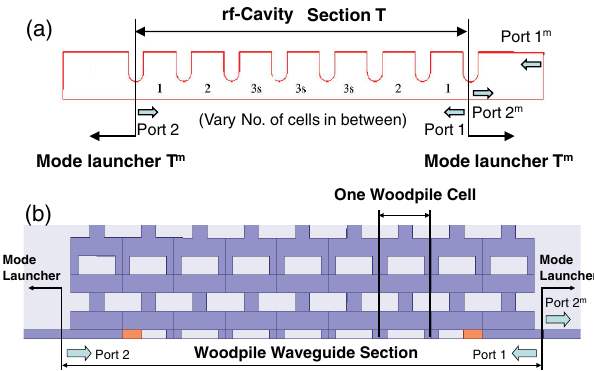
FIG. 3. (a) Mode launchers at the front and back of a multicell rf cavity waveguide to achieve traveling-wave match. (b) An equivalent configuration for a woodpile waveguide and back-to- back silicon guide mode